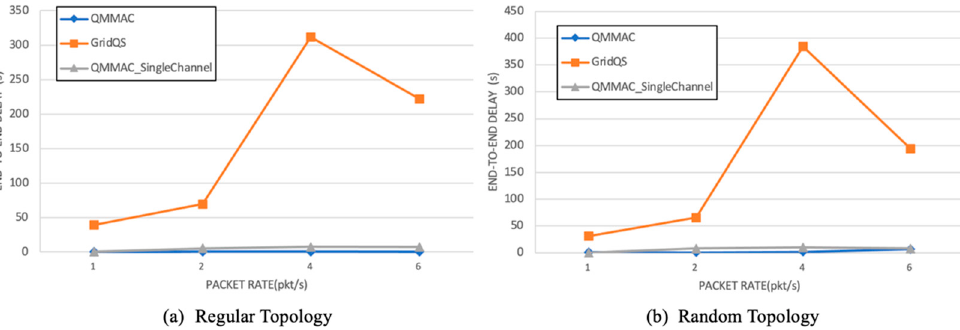
Figure 16. End-to-end delay.